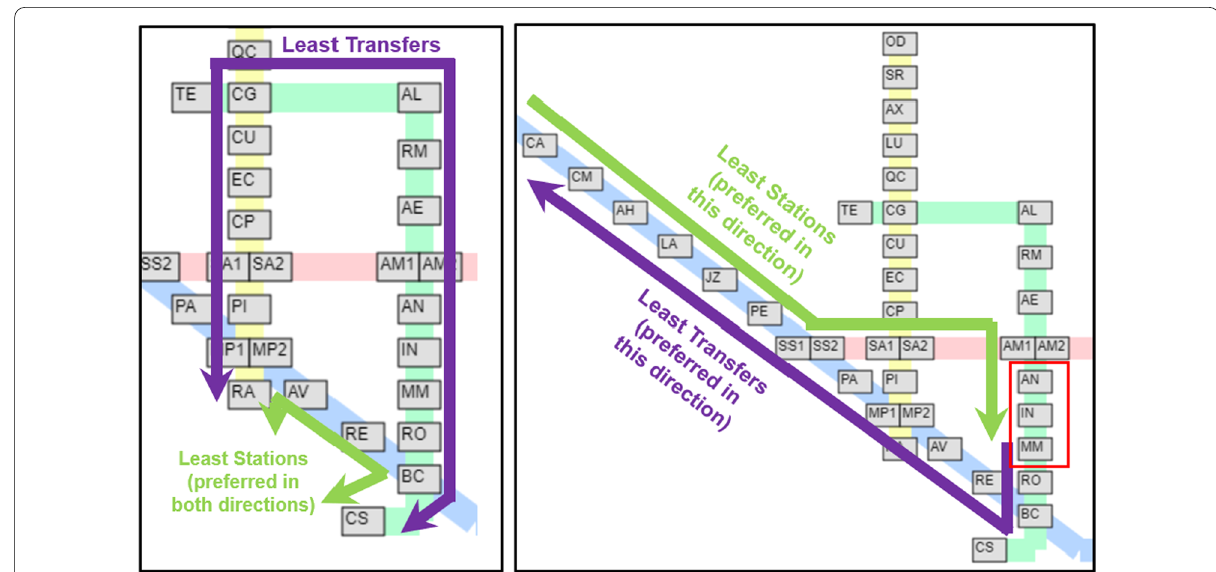
Table 2 Some examples among non‑trivial pair Entry station Exit station Least transfers route